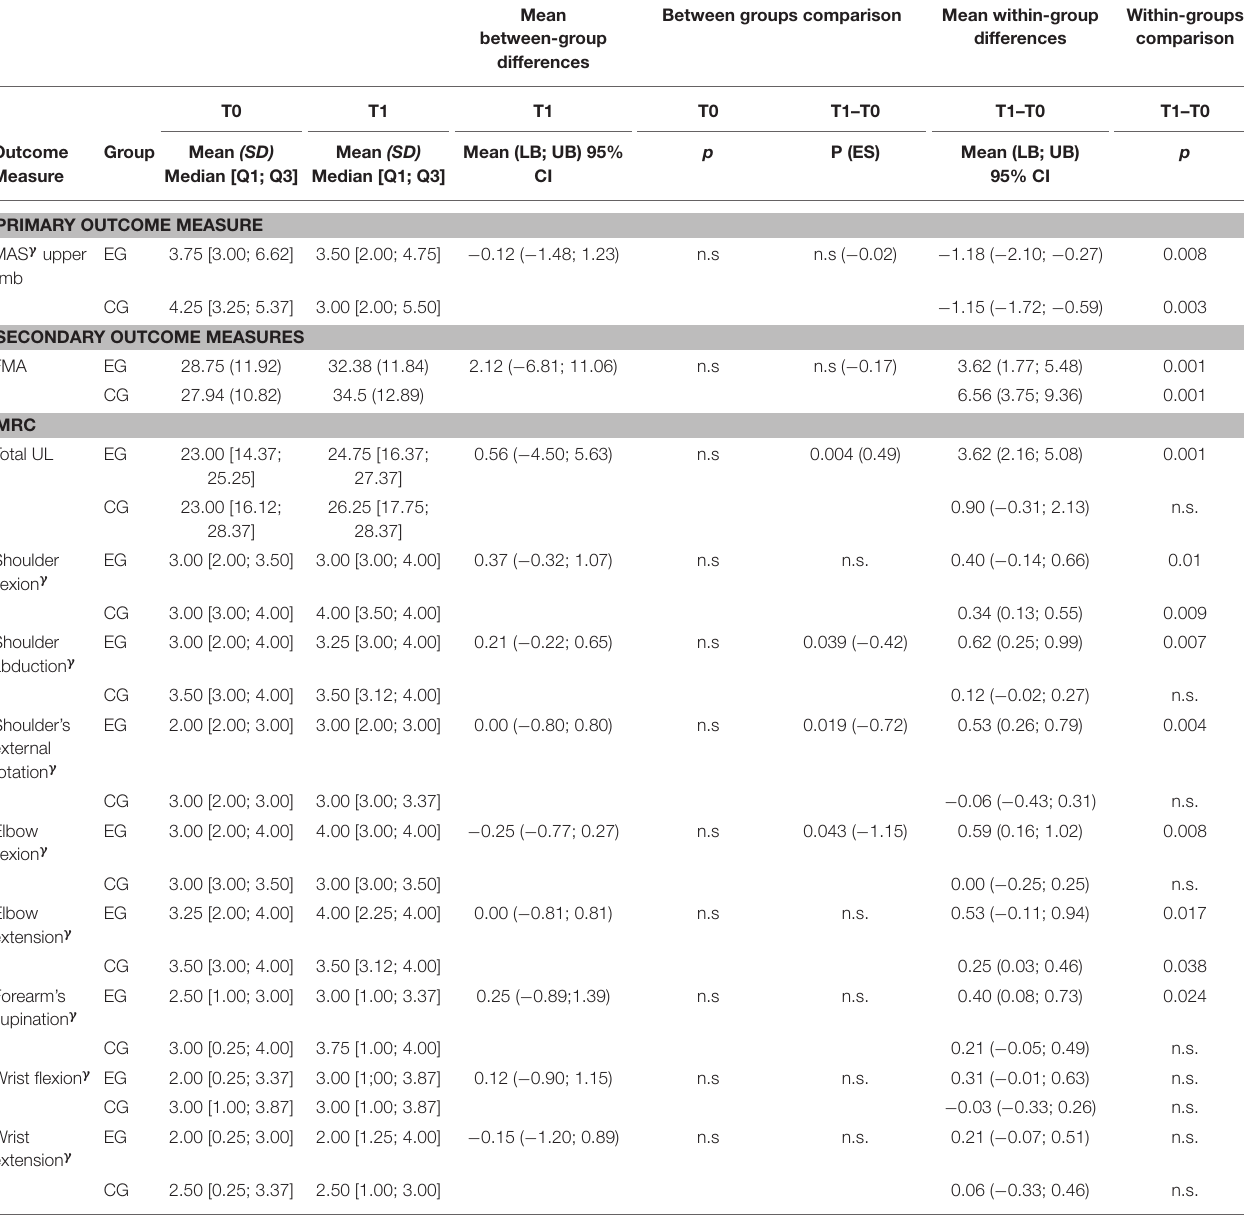
TABLE 2 | Clinical outcome measures and inferential statistics.